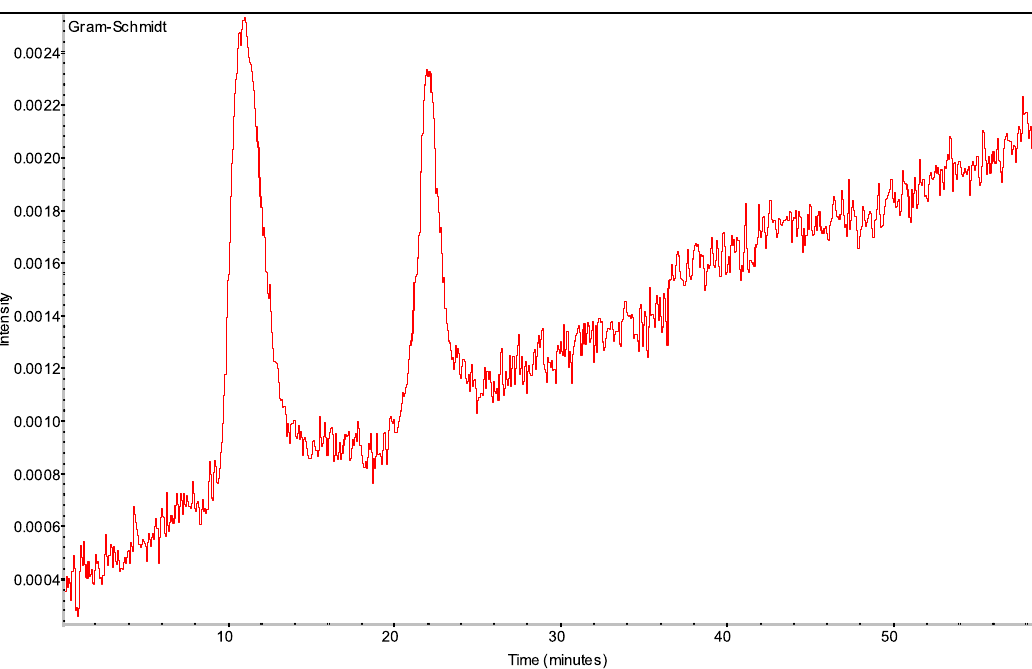
Figure 10. Gram-Schmidt of gas products from thermal decomposition of 1-nitroso-2-naphthol +